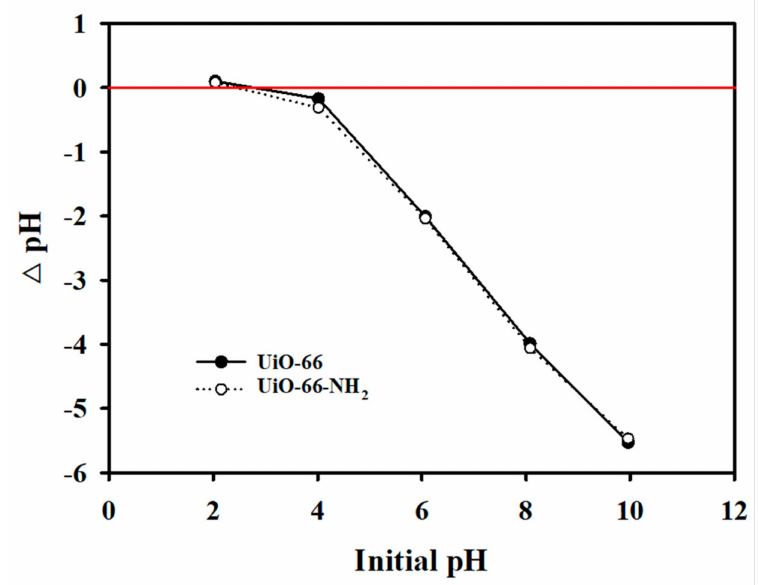
Figure 6. Point of zero charge (PZC) for UiO-66 and UiO-66-NH 2